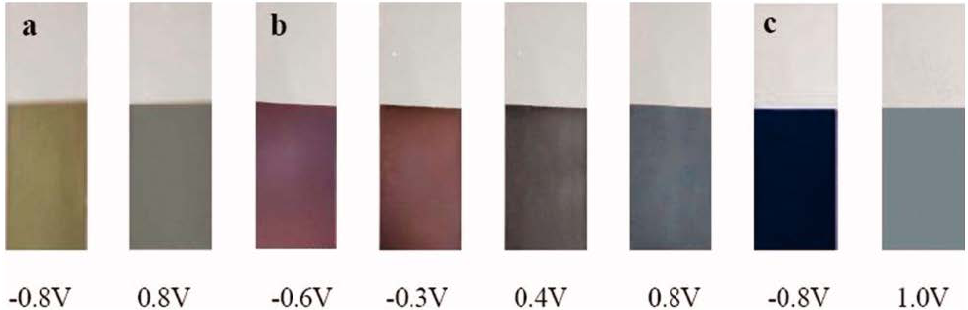
Figure 7. Optical images of ( a ) PPy; ( b ) copolymer of Py and 3,4-ethylenedioxythiophene; ( c ) poly(3,4- ethylenedioxythiophene). Reprinted with permission from Reference [109]. Published by John Wiley and Sons,